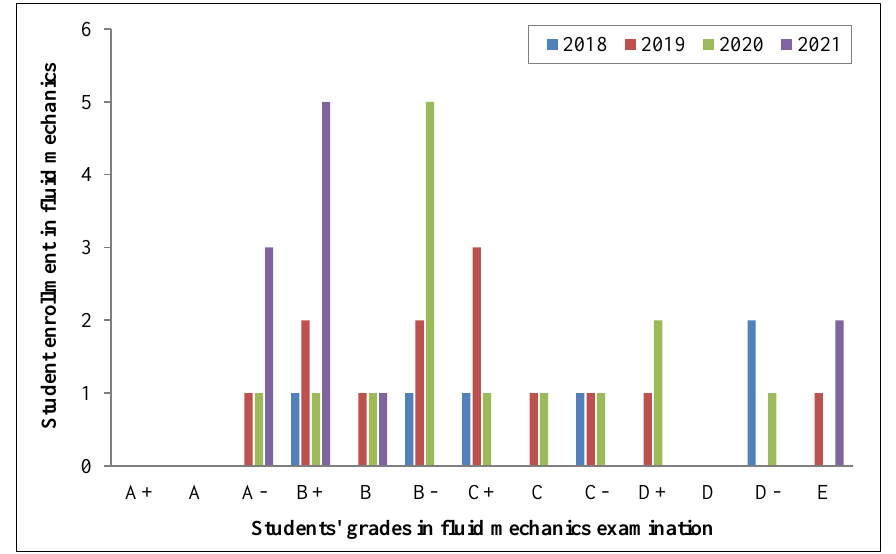
Figure 3. Grade distribution in Fluid Mechanics course across 4